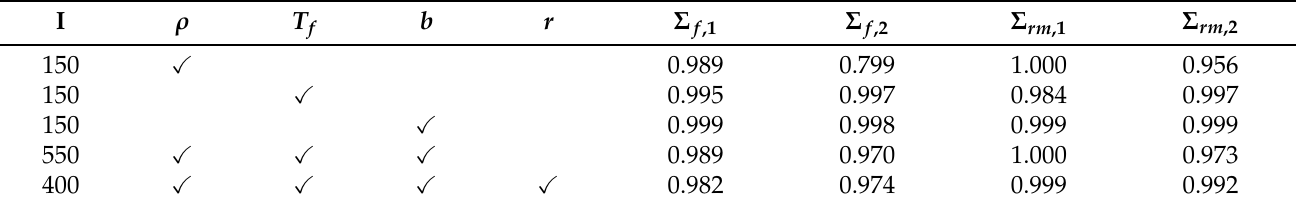
Table 2. Coefficient of determination using the CHM to fit to burnup sequence datasets with different varying state variables for the final burnup considered at 60 GWD/MTU. Checkmarks indicate varied state variables for each data set. I indicates the number of samples in the dataset.